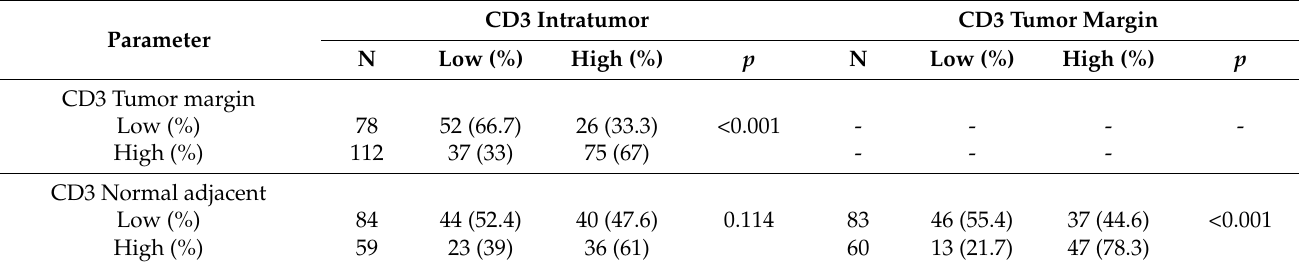
Table 3. Correlation of marker’s expression according to the different regions